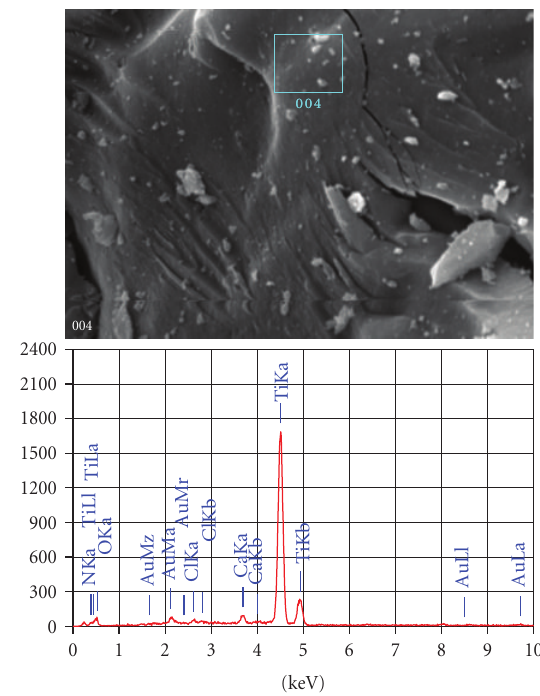
Figure 6: EDX spectra of N-doped mesoporous